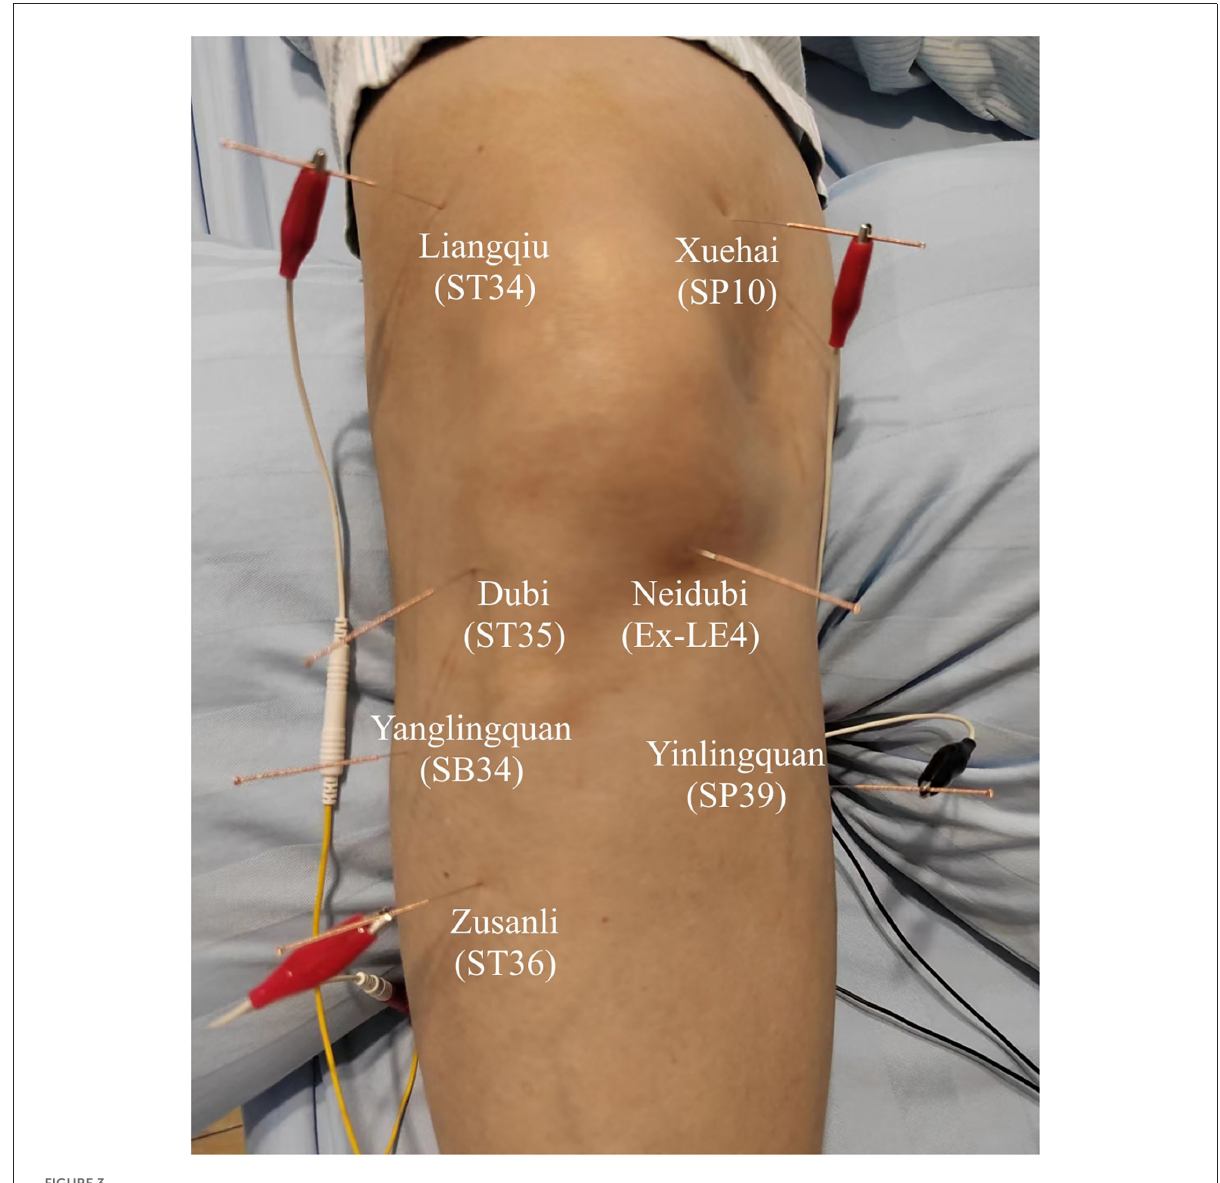
FIGURE3 Locations of